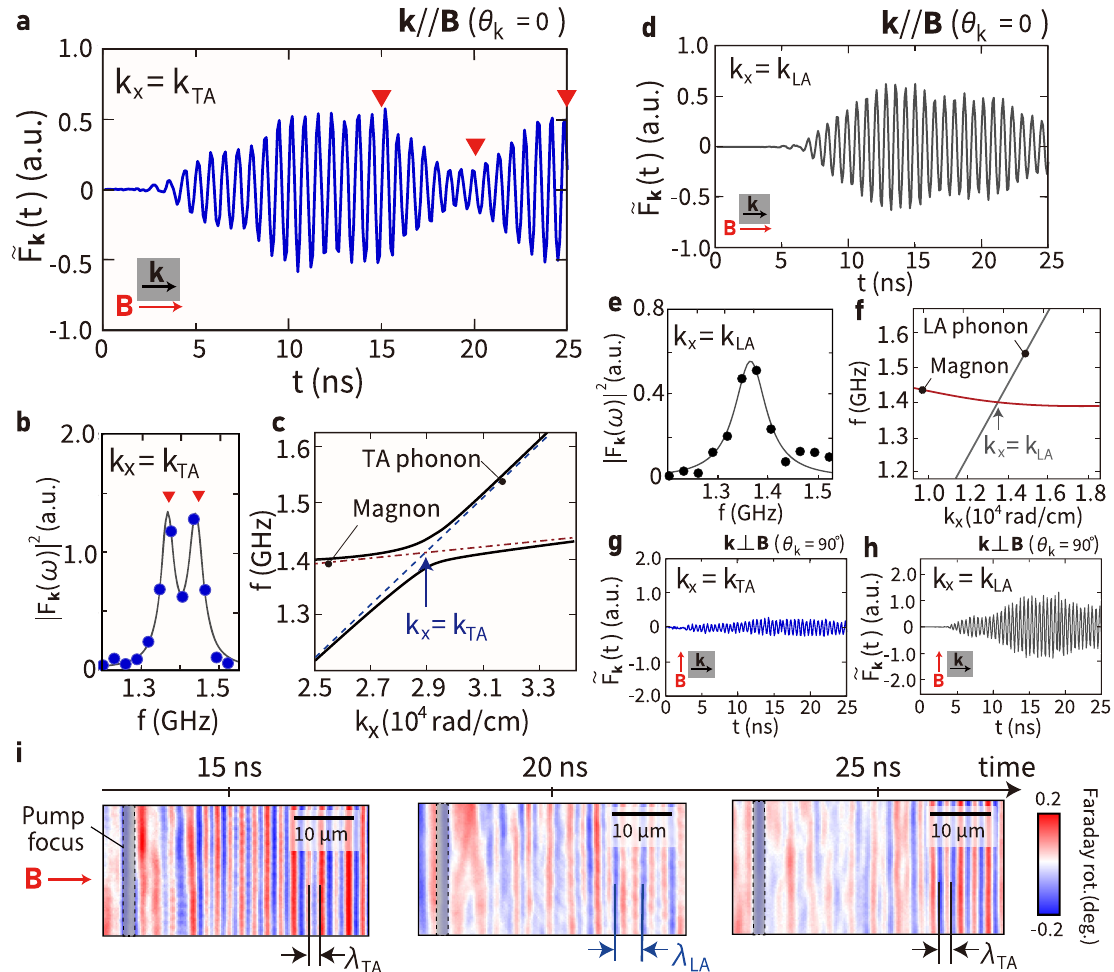
Fig. 2 Observation of magnon-phonon coherent oscillation. a Temporal evolution of the real part of ~ F k ð t Þ at k x = k TA under the magnetic fi eld B = 11.5 mT parallel to k , where k TA refers to the wavenumber of the intersection point between dispersion relations of transverse acoustic (TA) phonons and magnons. Red inverted triangles indicates t = 15 ns, 20 ns, and 25 ns after the pump pulse irradiation. b A frequency power spectrum of ~ F k ð t Þ at k x = k TA . The blue fi lled circles represents experimentally obtained spectrum intensity, while the gray curve represents fi tting curve. Inverted red triangle highlights peaks. Errors of the data are evaluated as a standard deviation, which is smaller than the data plot. c Theoretically calculated dispersion curves of magnon polarons around k x = k TA and k y = 0, where we use the crystalline anisotropy energy K c = 73.0 [J ⋅ m − 3 ], uniaxial anisotropy energy K u = − 767.5 [J ⋅ m − 3 ], saturation magnetization M s = 14.8 [kA ⋅ m − 1 ], velocity of LA phonons v LA = 6.51 [km ⋅ s − 1 ], velocity of TA phonons v TA = 3.06 [km ⋅ s − 1 ] and magnon- phonon coupling constant b 2 = 1.8 × 10 5 [J ⋅ m − 3 ]. The black solid curves represent the dispersion curves of magnon polarons, while the blue and red dashed curves represent pure TA phonons and magnons, respectively. d Temporal evolution of the real part of ~ F k ð t Þ at k x = k LA under the magnetic fi eld B = 11.5 mT parallel to k , where k LA refers to the wavenumber of the intersection point between dispersion relations of longitudinal acoustic (LA) phonons and magnons. e A frequency power spectrum of ~ F k ð t Þ at k x = k LA . The black fi lled circles represents experimentally obtained spectrum intensity, while the gray curve represents fi tting curve. Errors of the data are evaluated as a standard deviation, which is smaller than the data plot. f Theoretically calculated dispersion curves of magnon polarons around k x = k LA . The gray line and red curve represent the dispersion curves of LA phonons and magnons, respectively. g Temporal evolution of the real part of ~ F k ð t Þ at k x = k TA under the magnetic fi eld B = 11.5 mT perpendicular to k . h Temporal evolution of real part of ~ F k ð t Þ at k x = k LA under the magnetic fi eld B = 11.5 mT perpendicular to k . i , Magneto-optical images taken at different delay